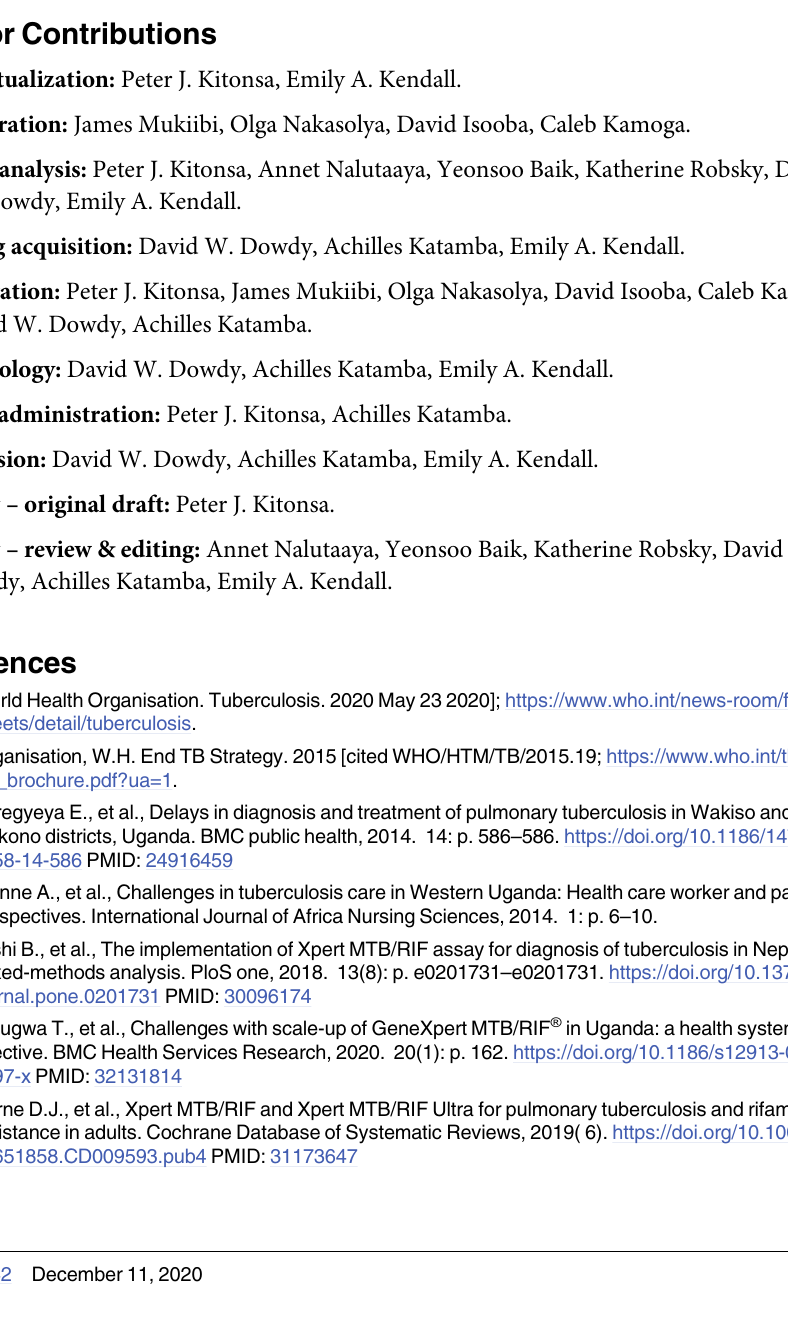
S3 Table. Positive predictive value (PPV) of symptom count plus two additional points for underweight status, using Xpert MTB/RIF as the reference standard for TB, at multiple cutoff values and multiple prevalences of